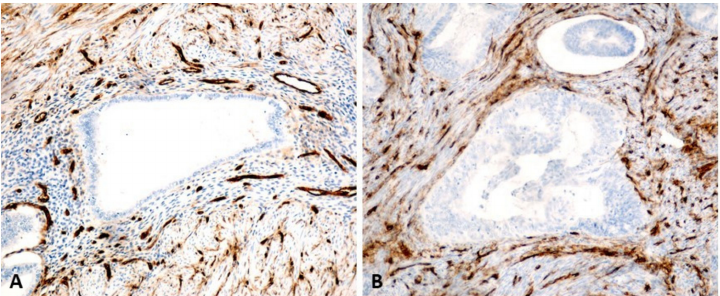
Figure 5. Vascularization in ectopic foci of endometriosis. ( A ) Adenomyosis. Endometrial epithe- lium, periglandular stroma, and periglandular vascularization (brown marking) are observed in the structure of the myometrium. ( B ) Hyperplastic transformed adenomyosis with atypical cellularity. Endometrial epithelium, periglandular stroma, and rich periglandular vascularization (brown mark- ing) of the myometrial structure. Immunostaining with anti-CD34 antibody, [ × 200]; CD34: cluster of differentiation 34.